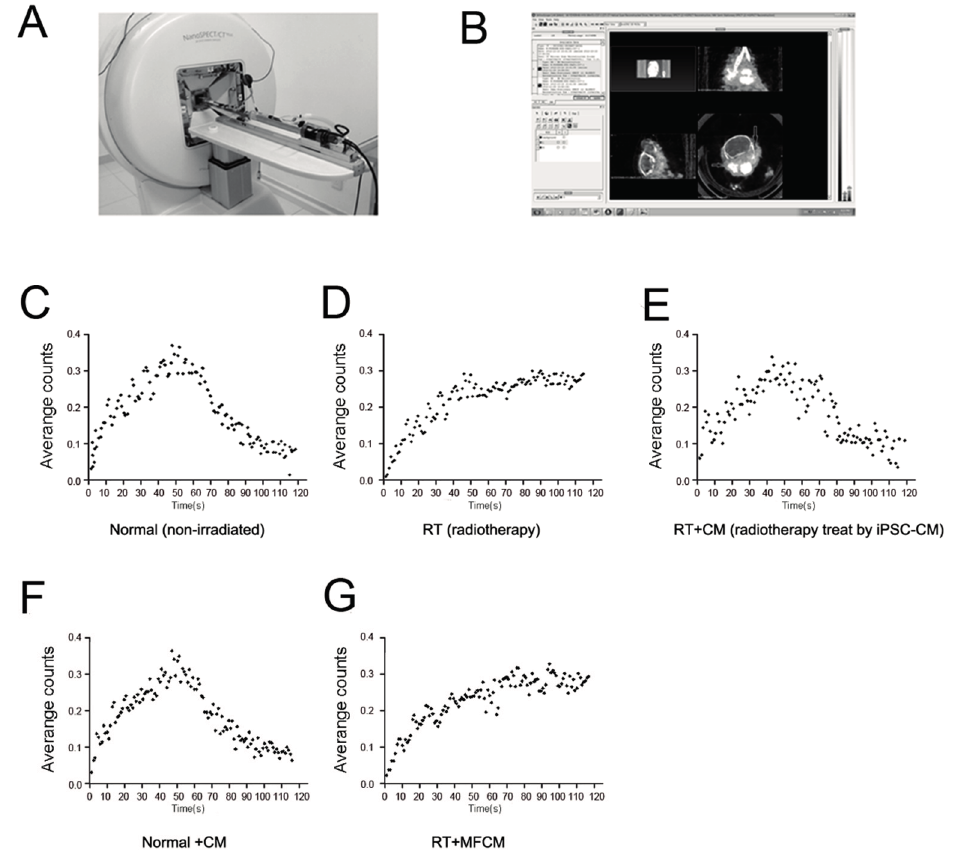
Figure 2. Supplementary figure. ( A ) The mice underwent sequential scintigraphy in a prone position with frontal projection of the head using a four-head camera; ( B ) Scintigraphic data analyzed by software; ( C – G) Time–activity curve of 99 mTc pertechnetate in the major lacrimal glands of mice in the five